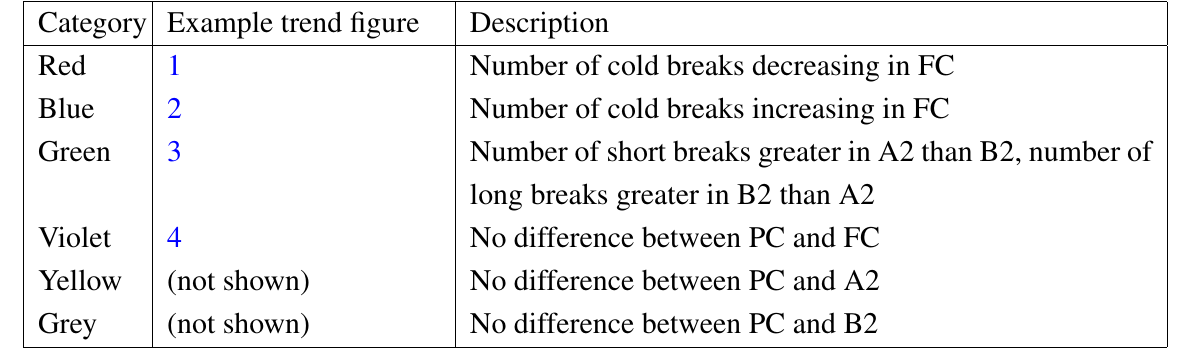
Table 1. Categorization of the set of qualitatively different behaviours of the frequency of cold breaks versus their